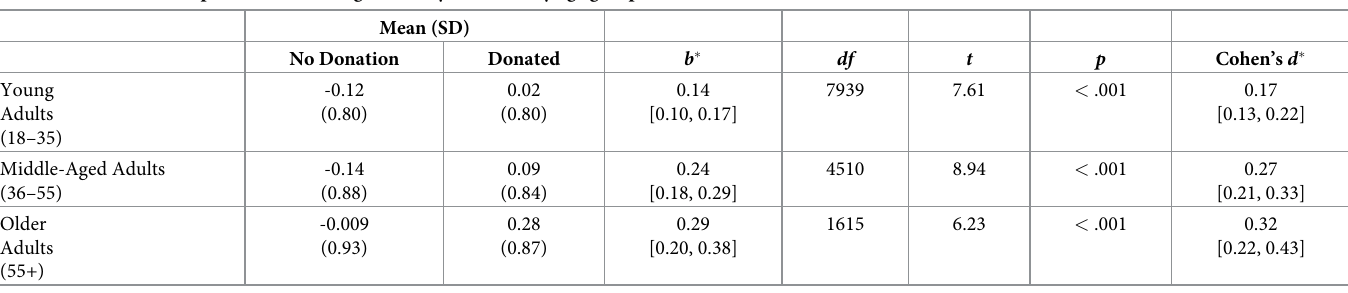
Table 2. The relationship between donating to charity and SWB by age